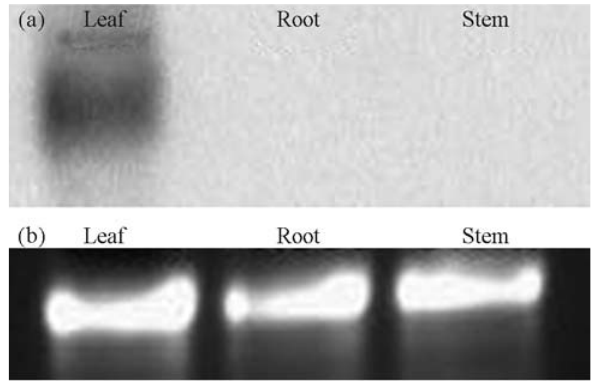
Figure 3 - (a) Northern blot analysis. Equal amount (20 μ g) of RNA from leaf, root and stem tissue was loaded and the membrane was probed with α 32 P labelled metallothionein type-2 homologue from P. nigrum . (b) 18SrRNA control. The equal intensity of 18SrRNA from all the three tis- sues serves as loading